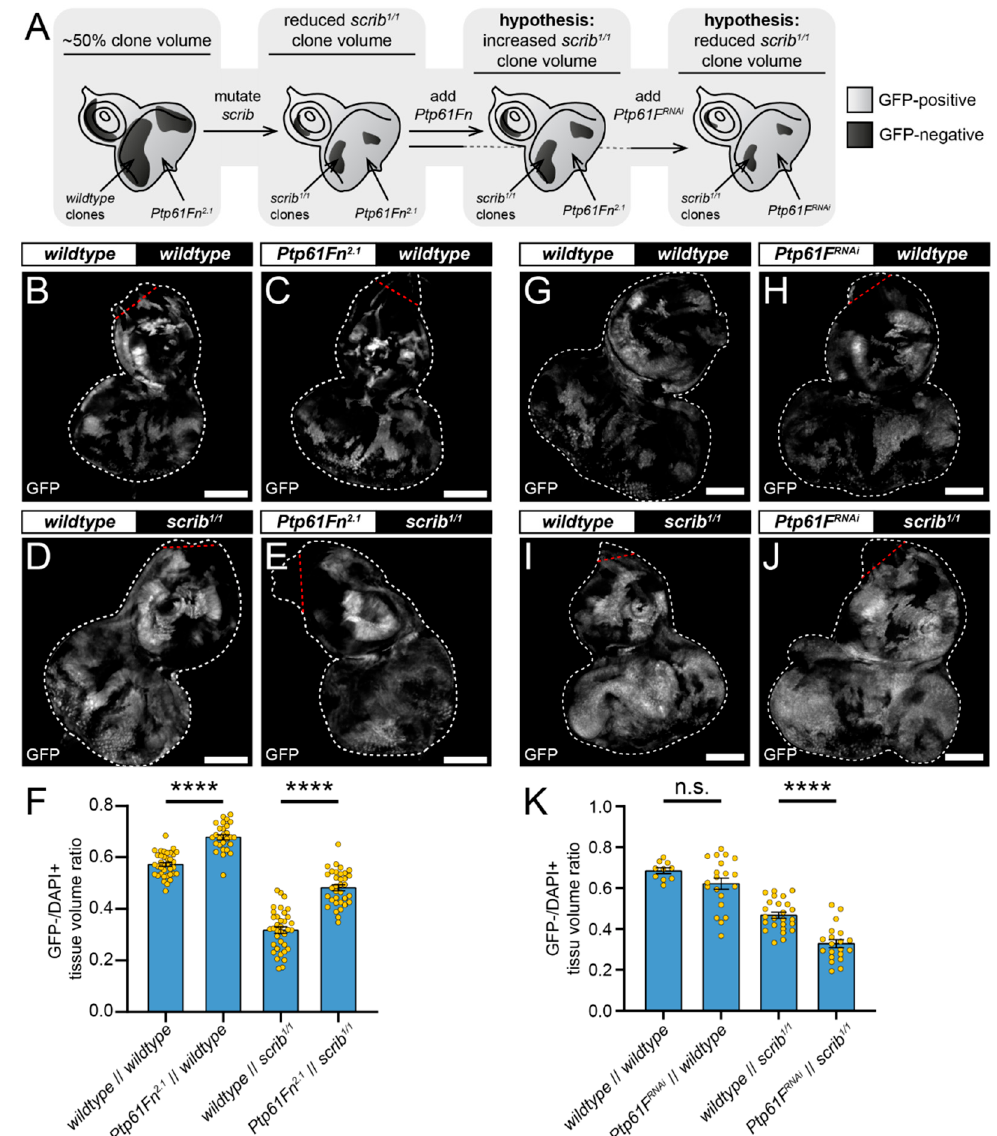
Figure 4. Nuclear-localised PTP61F expression reduces the relative fitness of wild-type cells during polarity-impaired cell competition. ( A ) Diagram of our experimental process and hypothesis. ( B – E , G – J ) Confocal images of L3 eye-antennal imaginal discs of the indicated genotypes (boxes at top, white indicates GFP-positive clones, black indicates remaining GFP-negative tissue) taken from animals where clones had been generated via revMARCM to express transgenes in cells that are otherwise wild-type , alongside cells that are GFP-negative and scrib -mutant. ( B , C ) When GFP-negative tissue is wild-type it makes up ~60% of the whole tissue when GFP-positive clones are wild-type (( B ); n = 36, 𝑥̅ = 0.572 ± 0.008), but Ptp61Fn 2.1 expression leads to the GFP-negative tissue making up ~70% of the total tissue volume (( C ); n = 27, 𝑥̅ = 0.679 ± 0.010), a statistically significant increase (Student’s t -test, d.f. = 61, t = 8.456, p < 0.0001). ( D , E ) When GFP-negative tissue is homozygous mutant for scrib 1 , it only contributes to ~30% of the whole tissue when surrounded by wild-type clones (( D );